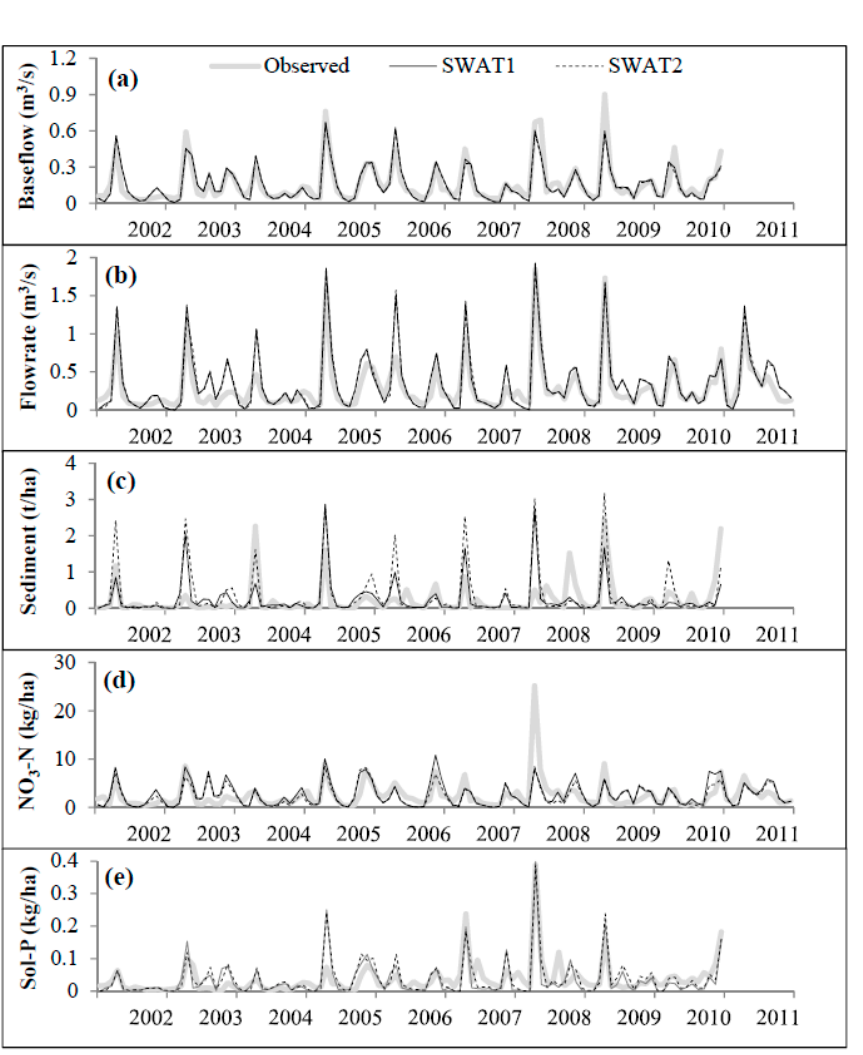
Figure 11. Comparisons of SWAT1- and SWAT2-simulated and observed monthly ( a ) baseflow, ( b ) flowrate, ( c ) sediment loading, ( d ) NO 3 -N loading, and ( e ) Sol-P loading for period ΙΙ . The “observed” values of baseflow were calculated using the RDF method. Table 5. Model assessments for SWAT1 and SWAT2 during two periods.